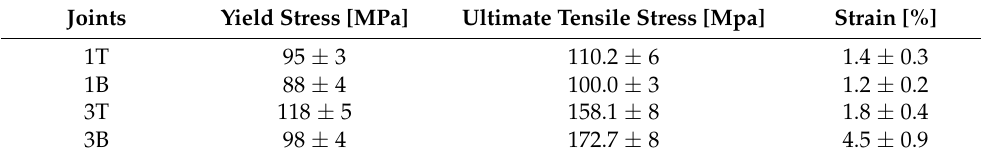
Table 3. Average results coming from tensile test of two specimens for joints 1T, 1B, 3T, 3B.